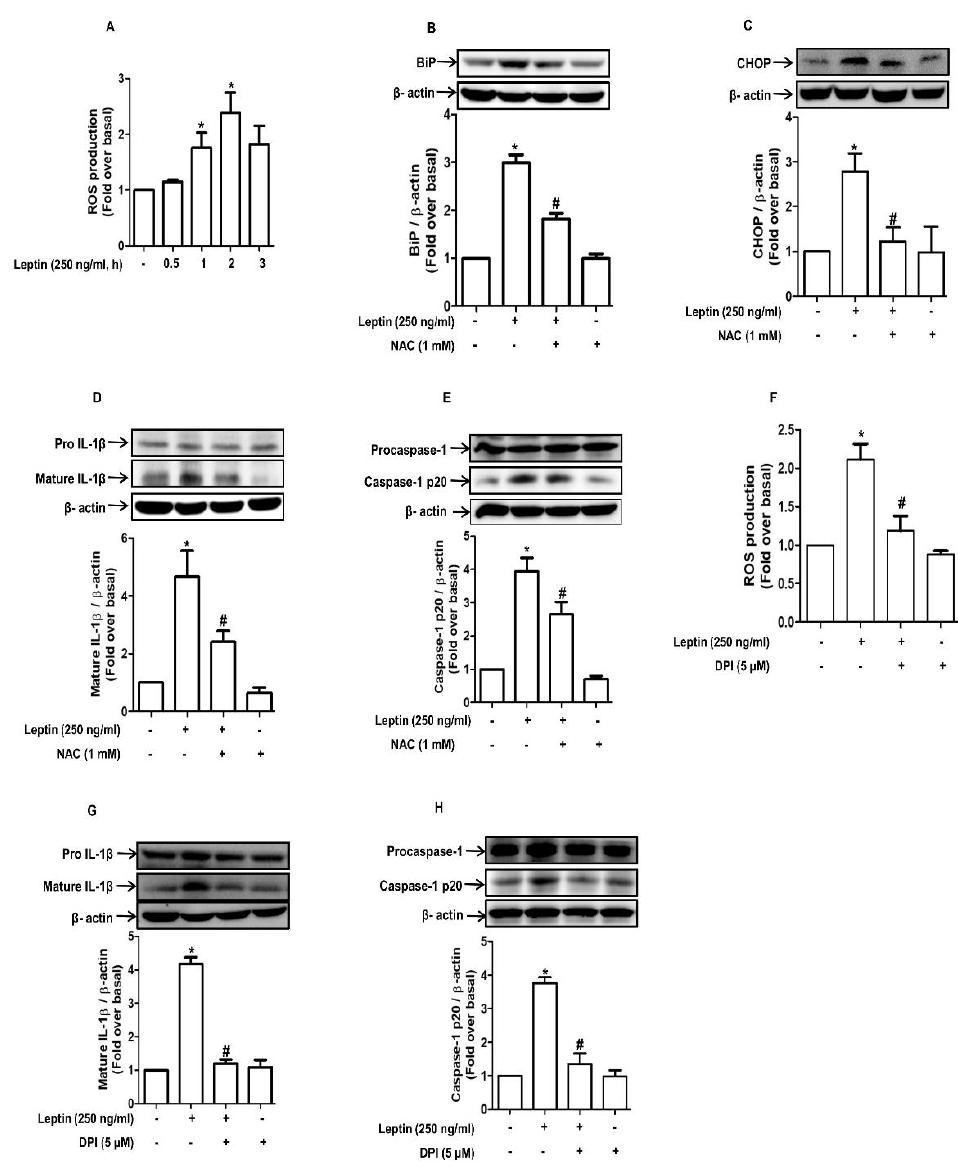
Figure 4. Role of ROS production in leptin-induced ER Stress and activation of inflammasomes in rat hepatocytes: ( A ) Cell were treated with leptin (250 ng/mL) for different time durations, and total ROS production was measured as indicated in the methods. ( B – E ) Hepatocytes were pretreaed with N-acetylcystein (NAC), a ROS scavenger, for 1 h followed by further treatment with leptin (250 ng/mL) for 8 h. Expression levels of BiP ( B ), CHOP (C), IL-1 β ( D ), and caspase-1 ( E ) were measured by Western blot analysis. ( F – H ) Hepatocytes were pretreated with diphenyleneiodonium (DPI), a pharmacological inhibitor of NADPH oxidase, for 1 h and were further stimulated with leptin for an additional 8 h. ( F ) ROS production was assessed by measuring the fluorescence of DCF. ( G , H ) Expression levels of IL-1 β ( G ) and caspase-1 ( H ) were determined by Western blot analysis. For Western blot analyses, expression levels of the genes were quantitated by densitometric analysis and are presented in the lower panel of each image. Values are presented as fold changes in comparison to the control group and are expressed as mean ± SEM, n = 3. * represents p < 0.05 compared to control cells; # represents p < 0.05 compared to the cells treated with leptin